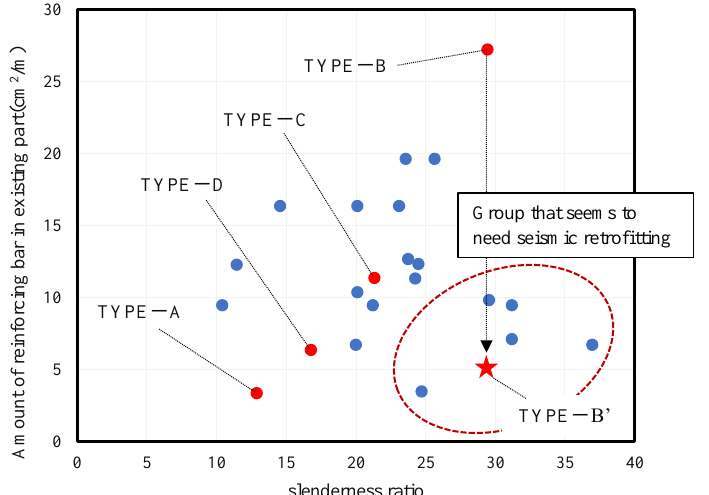
Figure 36. Classification of dams by slenderness ratio and amount of reinforcing bars (Added TYPE- B’).